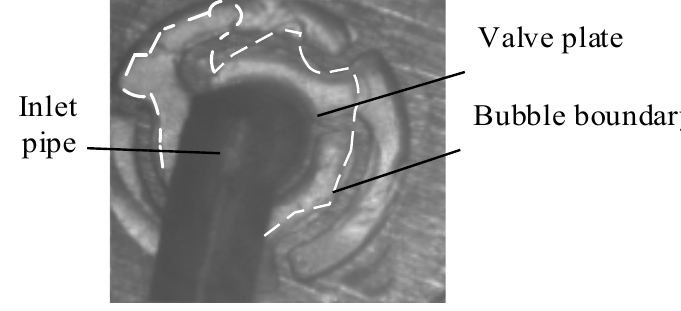
Figure 2. Bubble stayed around inlet valve.